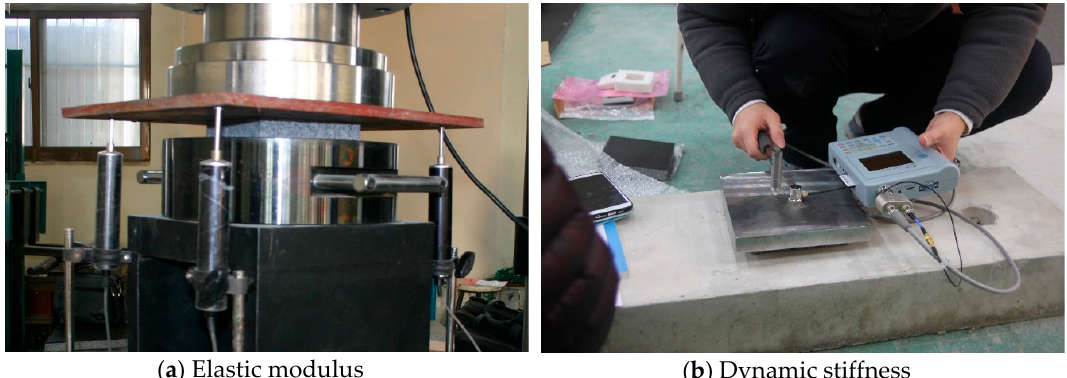
Figure 3. Measurement of elastic modulus and dynamic stiffness.